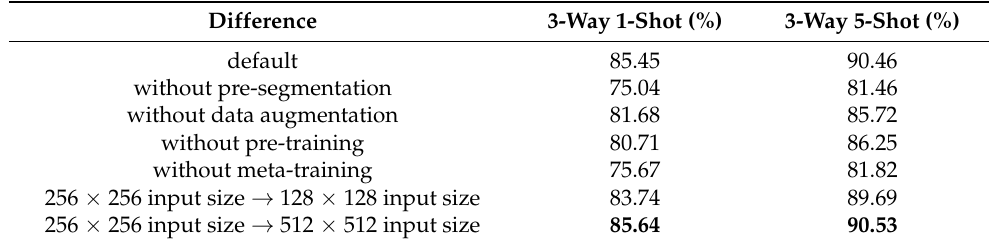
Table 7. Ablation study using DenseNet121-PS-MC on the Test2 test set; “default” indicates the base model, “without” indicates the removal of the component from the base model, “input size” indicates the scale of the input settlement environment map, and the arrow indicates the adjustment made. The best metrics are highlighted in bold